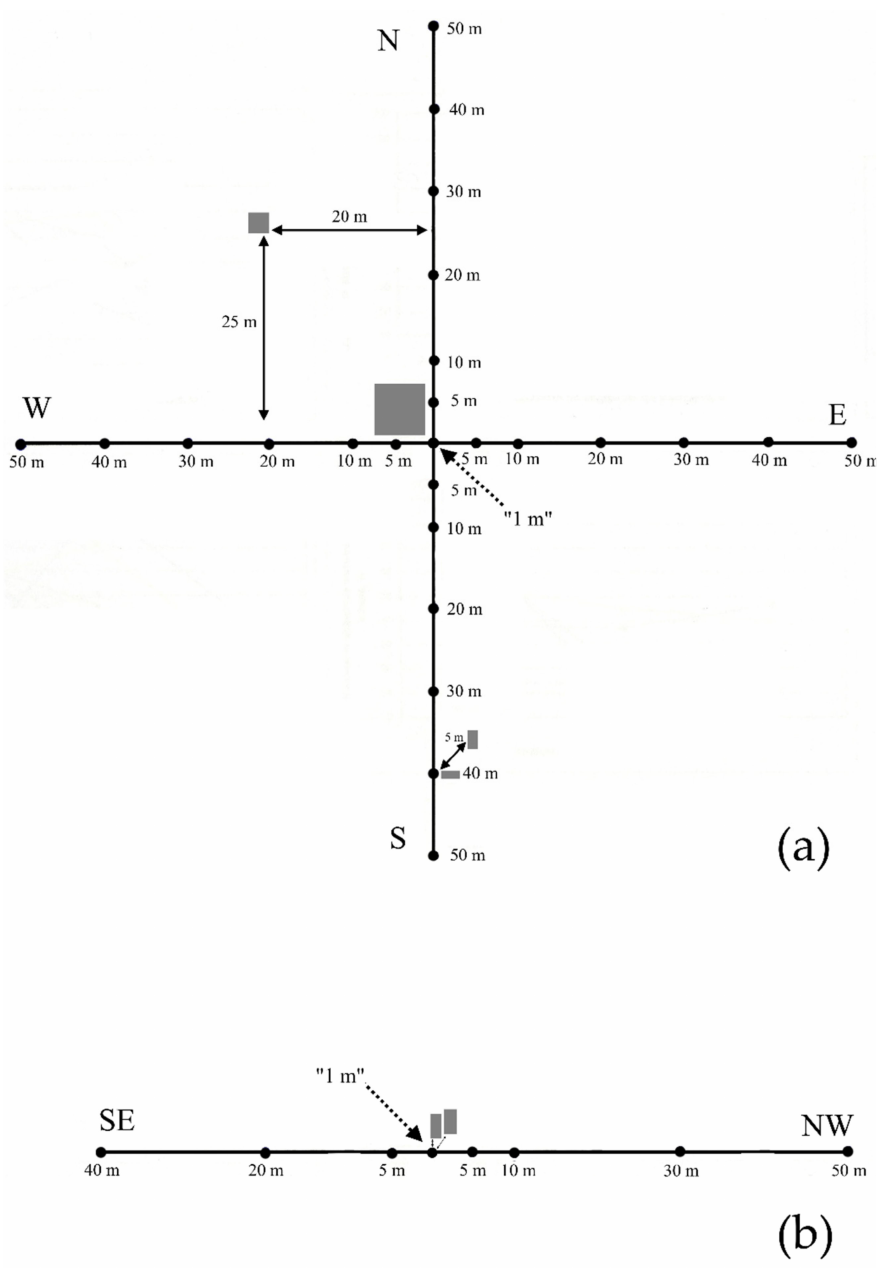
Figure 2. Location of sampling points and groups of Heterobasidion annosum s.l. fruiting bodies: ( a ) the Kalsnava sample plot and ( b ) the Tireli sample plot). Relative area of H. annosum s.l. fruiting body hymenophores; dashed line with arrow shows the cross point of transects located 1 m from the largest group of H. annosum s.l. fruiting